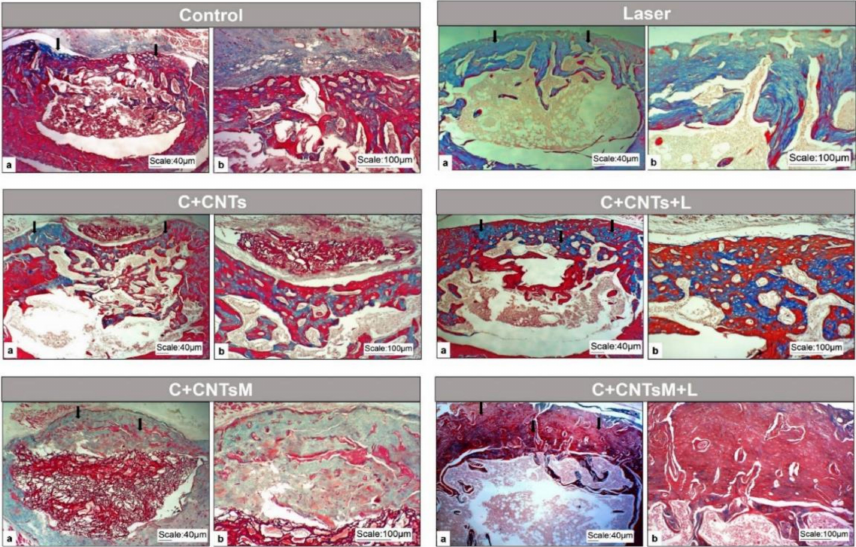
Figure 6. Optical microscope images of the bone defect created in the distal metaphysis of the femur of rats in the study groups, ( a ) panoramic view and ( b ) detailed view. Defect areas are indicated by black arrows. Note the neoformed bone in the surgical area, is more dense and voluminous in G6/C+CNTsM+L. Masson trichrome.